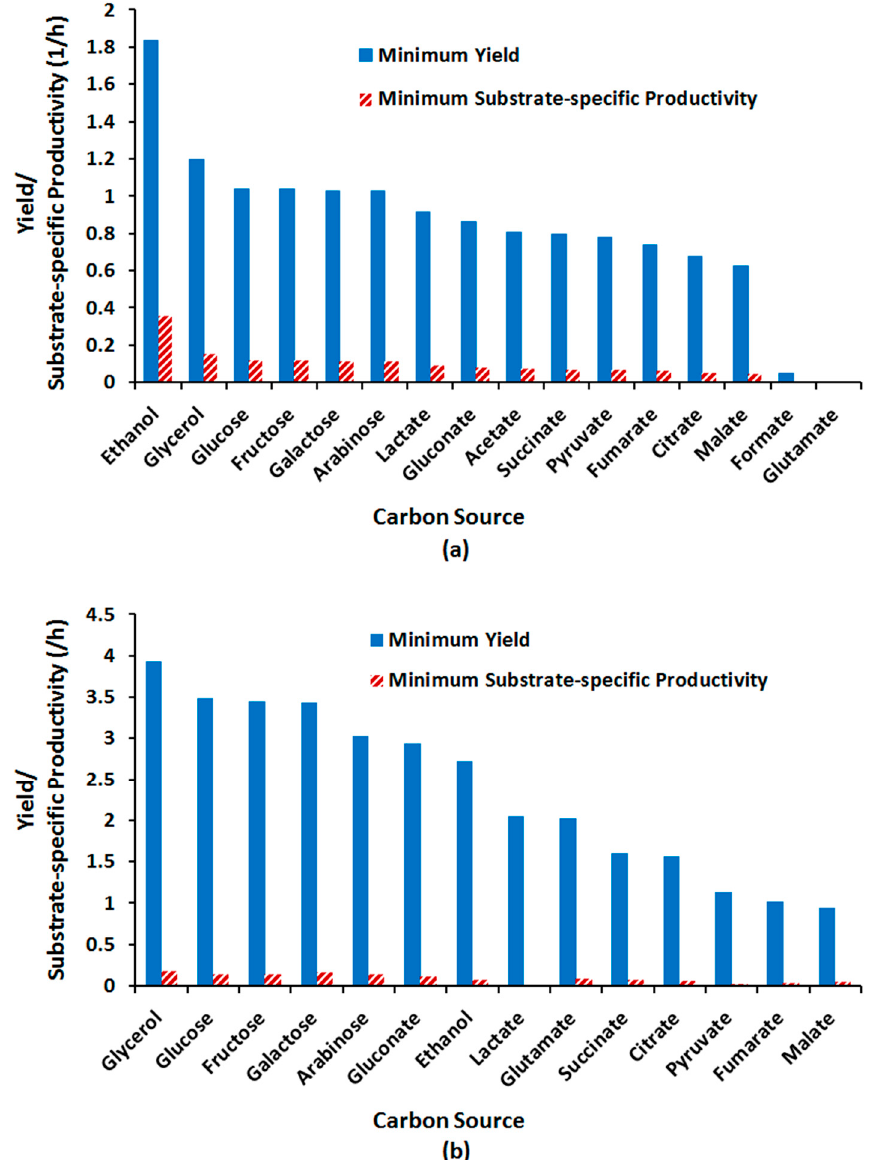
Figure 12. Assimilatory TNT biotransformation yield for various carbon sources as (co)substrate under ( a ) aerobic and ( b ) anaerobic growth regimes.